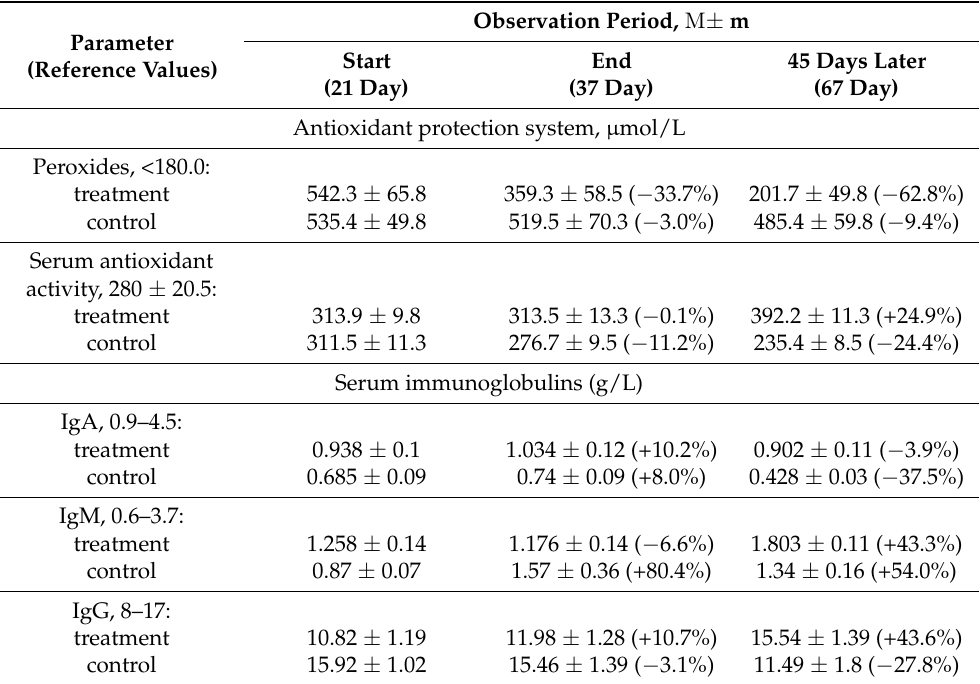
Table 9. Antioxidant defense system and serum immunoglobulins during the period of food inter- vention (absolute values).